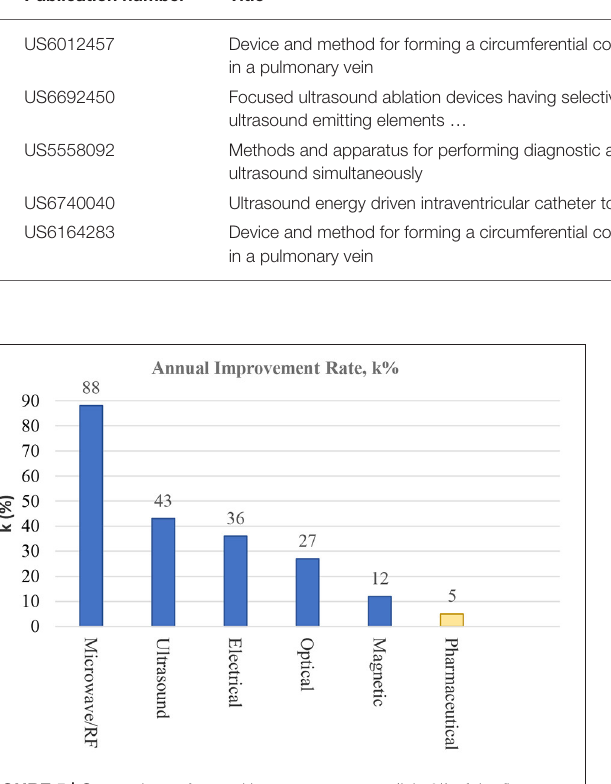
FIGURE 5 | Comparison of annual improvement rates ( k in %) of the five energy-based therapeutic domains. The k values are presented in descending order, and the aggregate k value for the pharmaceuticals is presented for